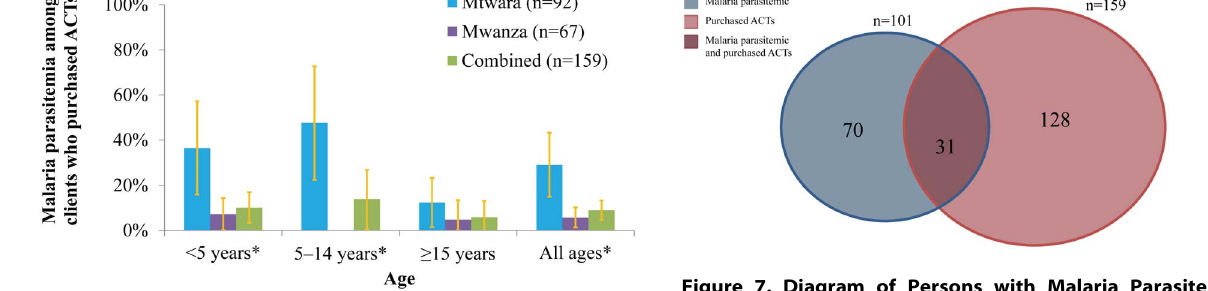
Figure 7. Diagram of Persons with Malaria Parasitemia vs. Persons who Purchased ACTs. *101 (13.0%) persons had malaria parasitemia. 159 (20.5%) persons purchased ACTs. 31 (30.7%) of those with malaria parasitemia purchased ACTs. 128 (80.5%) of those who purchased ACTs did not have malaria